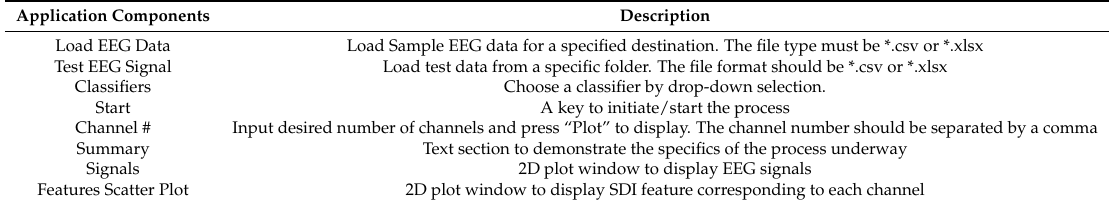
Figure 9. Performance parameters of FFNN classifier for Dataset V. Table 6. CADMMI-SDI